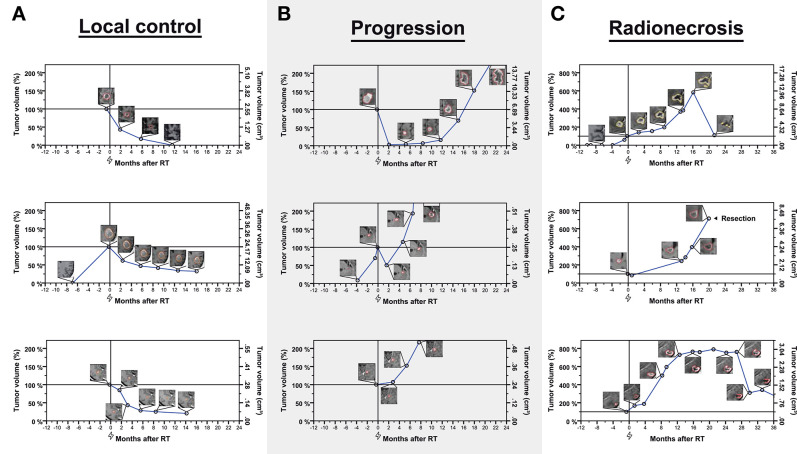
Examples of longitudinal volumetry in nine brain metastases classified as controlled (A—left column), experiencing progression (B—middle columns), or radionecrosis (C—right column). Tumor volumes are expressed relative to baseline volume (left y-axis) over time. The right y-axis shows the absolute metastasis volume in cm3. The flash symbol indicates the time of radiotherapy (0 months−100% relative tumor volume). Inlay images show segmented metastases for different measurements. In total, 972 time points in 190 brain metastases were used in this study (average of 5.1 per metastasis).